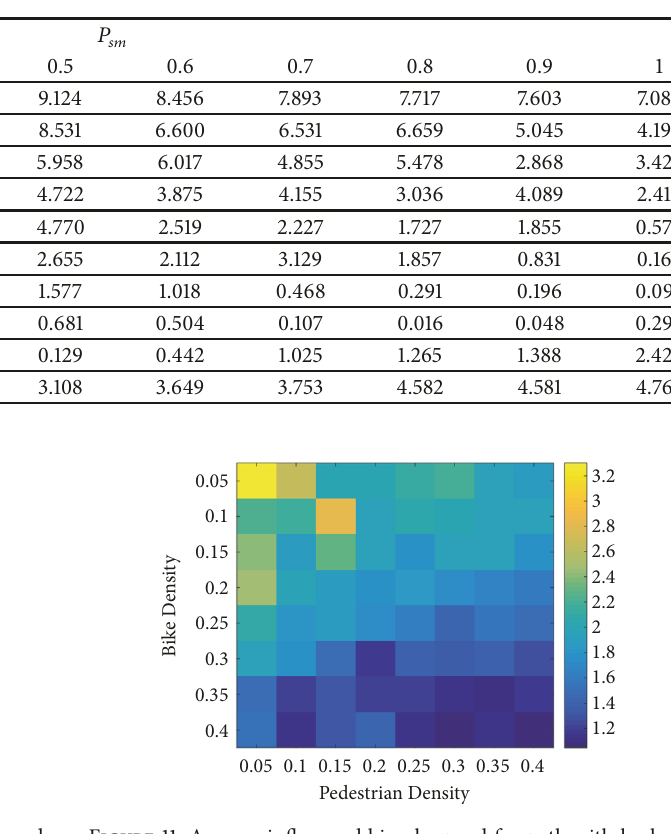
Table 1: The least sum square (LSS) of speed differences with different probability of a bicycle to randomly slow down.